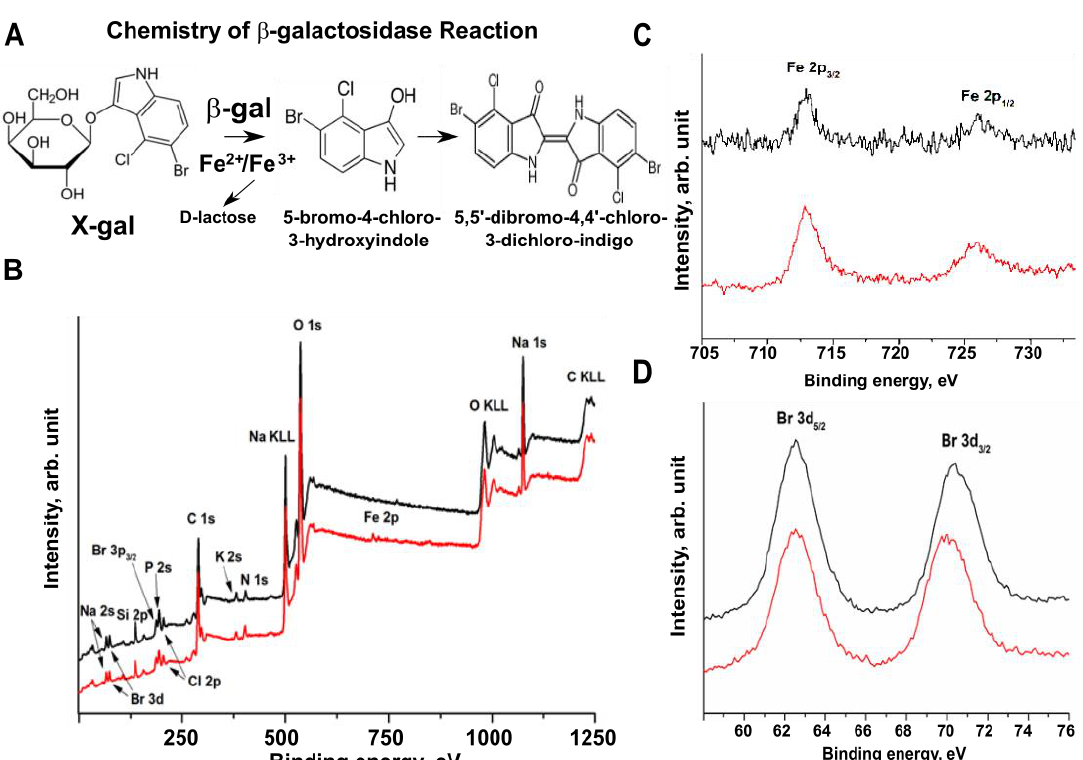
Figure 5. XPS analysis of the β -galactosidase enzymatic reaction products. ( A ) Schematic representation of the β -gal reaction in vitro. ( B – D ) X-ray photoemission spectroscopy (XPS) analysis of the β -gal reaction products: black lines— β -gal reaction performed with X-gal/FeCN substrate; red lines—X-gal/FeCN substrate only; ( B ) complete survey spectra of the β -gal reaction products; ( C , D ) regions of main photoemission spectra Fe 2p ( C ) and Br 3d ( D ) peaks; black lines—reaction of β -gal with X-gal/FeCN substrate; red lines—X-gal/FeCN substrate only. KLL- auger transition; β -gal- β